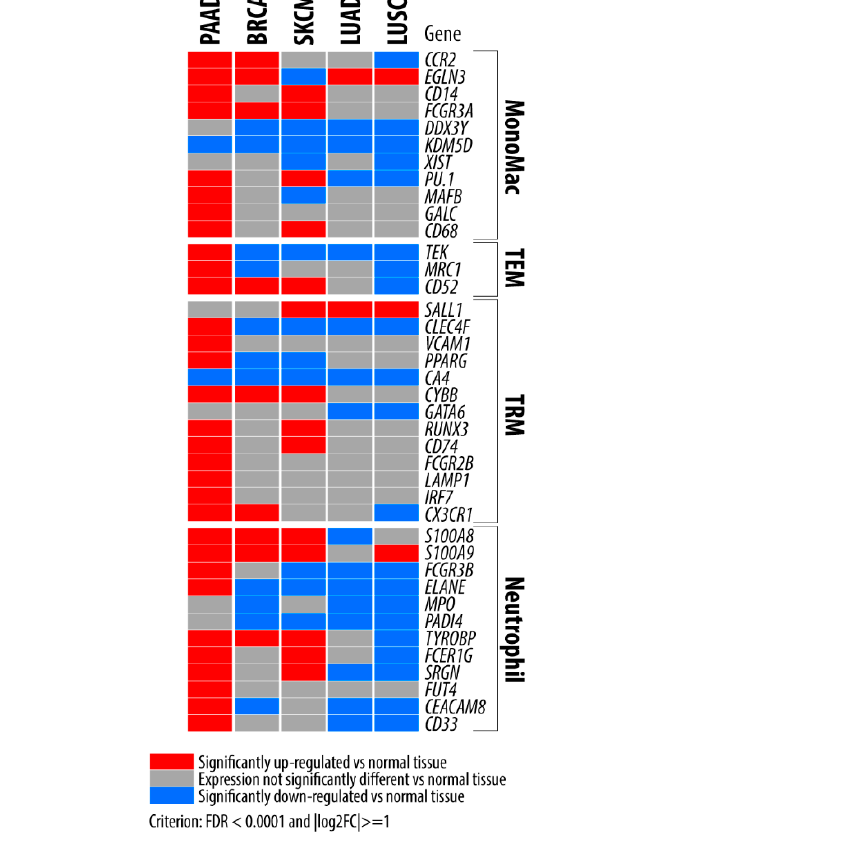
Figure 1. Gene expression in tumor type relative to its normal tissue. We used the TCGA TARGET GTEx cohort from the UCSC Xena platform [21], which has 60,498 gene variants in total and combines normalized samples from both TCGA and GTEx. Since the data in [22] has log 2 (x + 1)-transformed RSEM expected count values, the exponent was taken, and a unity subtracted to obtain the isoform-level estimates. Five TCGA projects (PAAD, pancreatic adenocarcinoma; BRCA, breast invasive